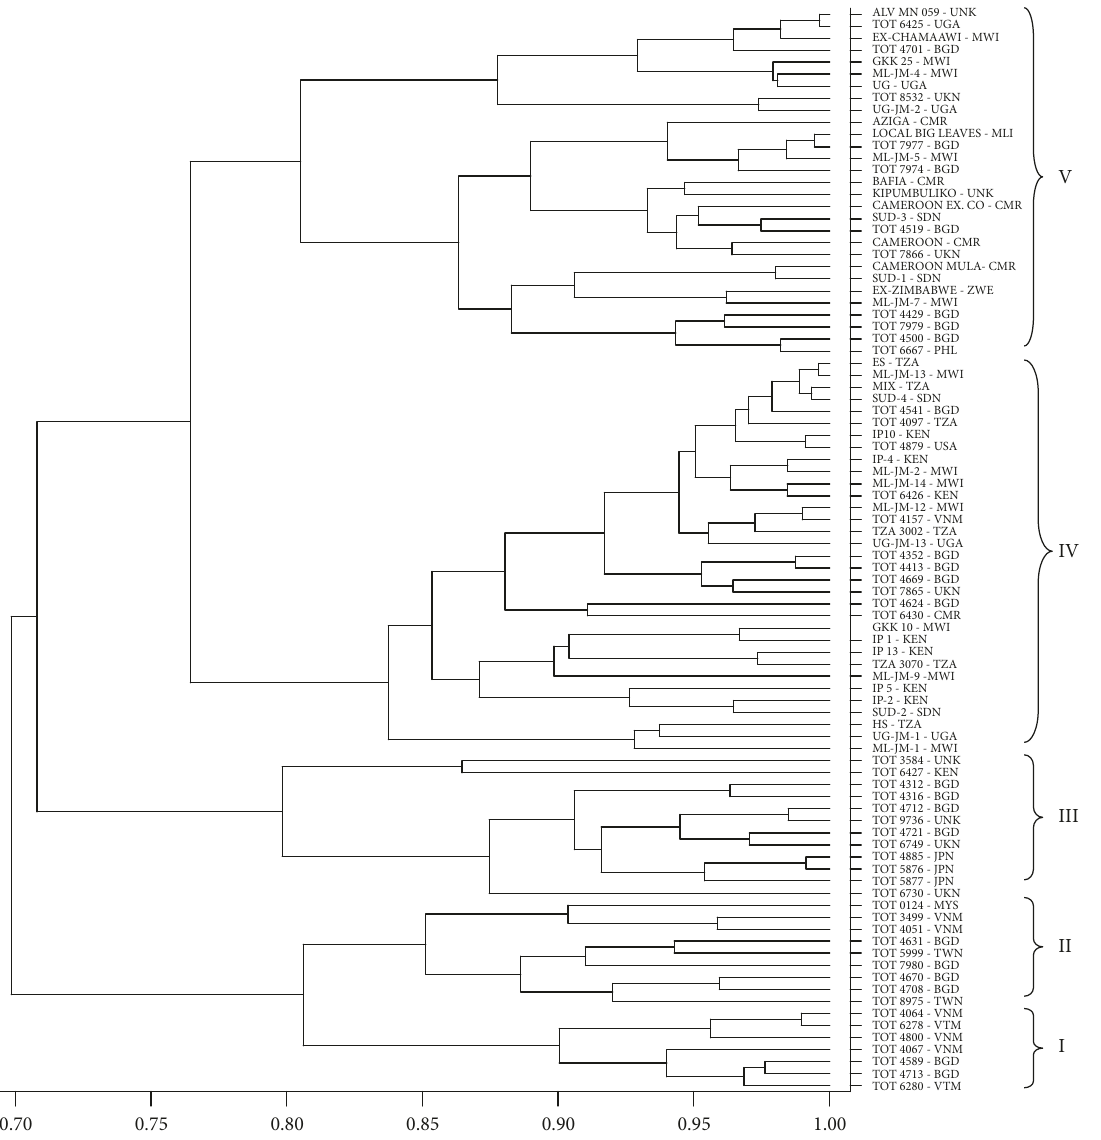
Figure 3: Dendrogram of 90 accessions of Corchorus spp. explained by complete linkage clustering of 19 quantitative traits and 14 qualitative traits. The source of accessions is indicated by the country code of respective accession and UKN represents unknown accession.